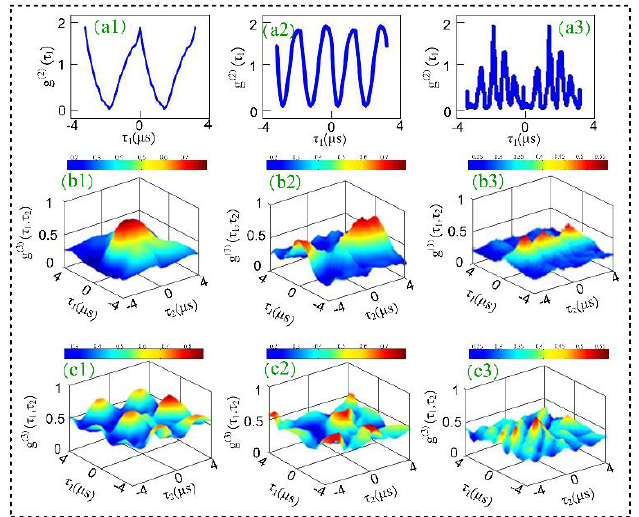
Figure 4. ( a ) The second-order temporal correlation of two pseudo-thermal sources by changing t 1 time offset when the power of E 1 is fixed at 1 mW. ( a1 ) t 1 = 0 μs; ( a2 ) t 1 = 1 μs; ( a3 ) t 1 = 2 μs; ( b , c ) The third-order temporal correlation of two pseudo-thermal sources when when the power of E 1 is fixed at 1 mW and 3 mW, respetively. ( b1 ) t 1 = 0 μs; ( b2 ) t 1 = 1 μs; ( b3 ) t 1 = 2 μs; ( c1 ) t 1 = 0 μs; ( c2 ) t 1 = 1 μs; ( c3 ) t 1 = 2 μs.